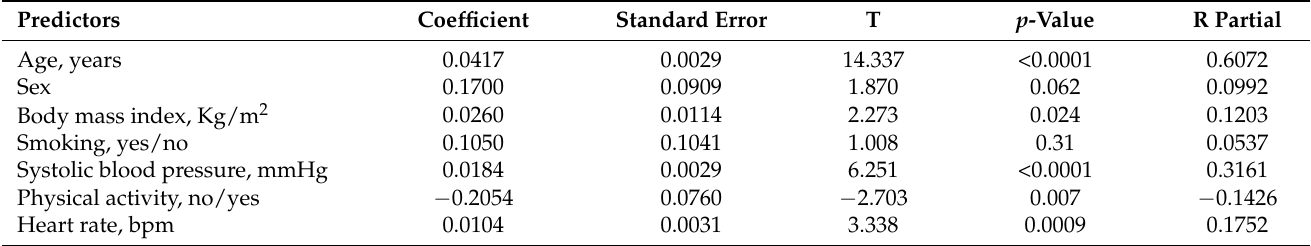
Table 3. Predictors of one-point pulse wave velocity in a multivariable linear regression analysis. Data from 360 subjects.